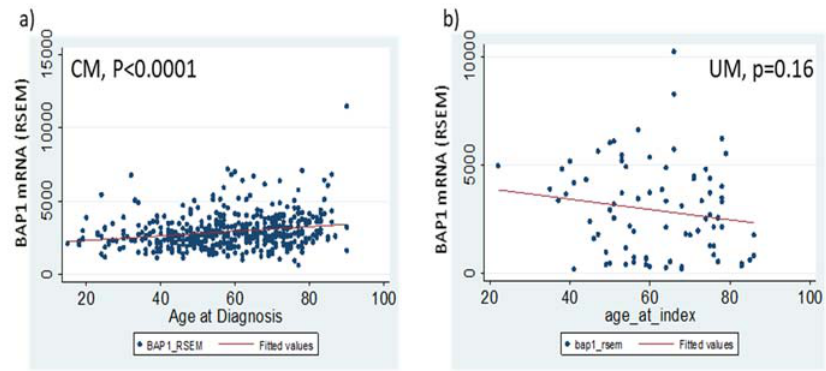
Figure 2. The trend of BAP1 mRNA expression along age axis in CM ( a ) and UM ( b ). Scatter plots of BAP1 RSEM (RNA-Seq by Expectation Maximization) estimates in each tumor with age of diagnosis as X axis. CM tumors were grouped by median mRNA Z scores ( ± 2.0) and screened for BAP1 co-expressed genes. Table 3. Correlation of age with BAP1 mRNA levels in CM and age-specific survival analysis. t -Test, p = 0.0004 Cox Survival Analysis